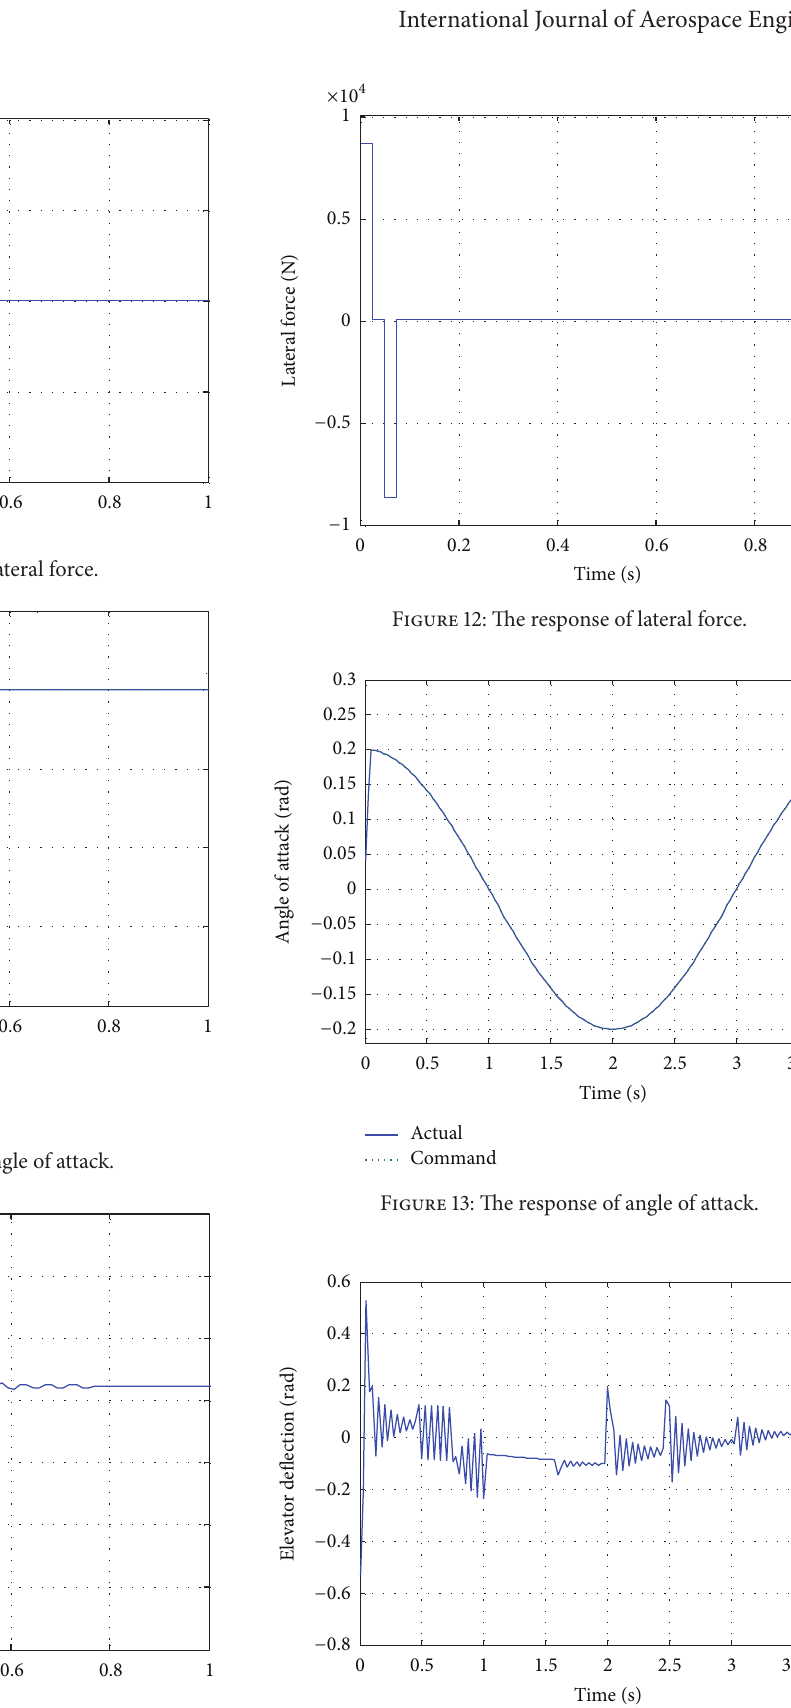
Figure 14: The response of elevator